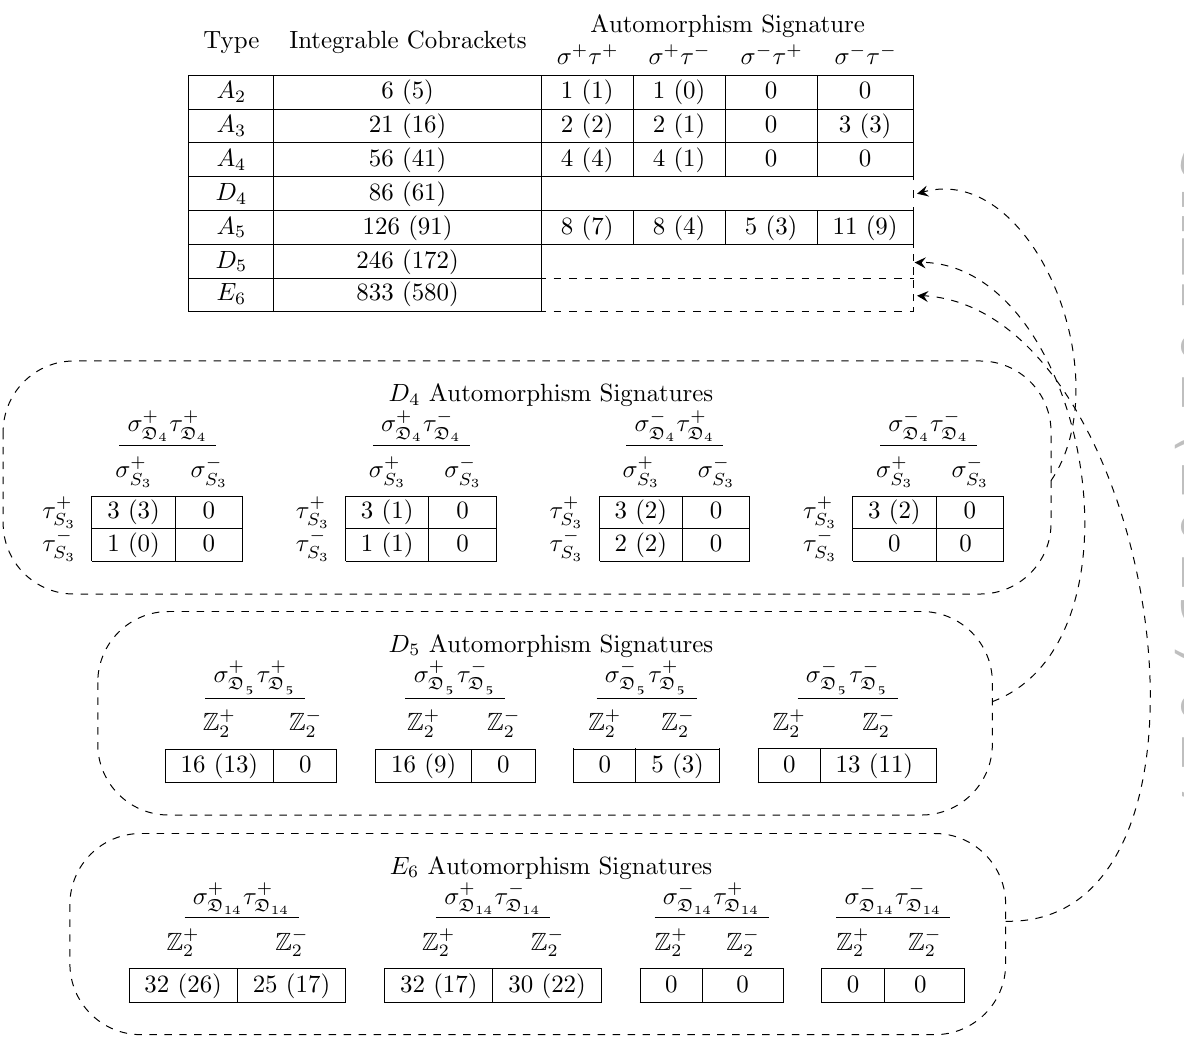
Table 6. The number of weight-four cluster polylogarithms on various (cid:12)nite cluster algebras that have nonzero cobrackets, prior to consideration of their automorphism group and after requiring speci(cid:12)c automorphism signatures. The number of polylogarithms that can also be made to satisfy cobracket-level cluster adjacency is given in